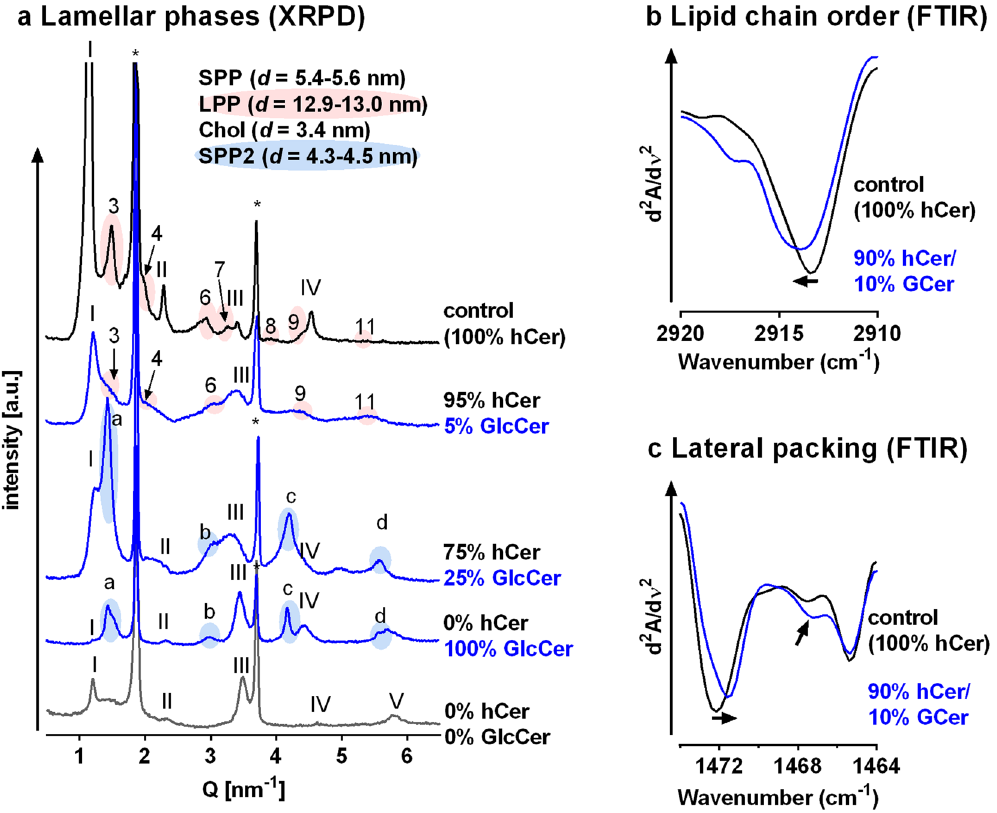
Figure 3. Lamellae phases, lipid chain order and lateral packing of selected hCer/GlcCer/FFA/Chol/CholS membranes studied using X-ray powder diffraction (XRPD; a ) and Fourier transform infrared spectroscopy (FTIR; b and c ). Roman numerals mark the short periodicity phase (SPP); Arabic numerals mark the long periodicity phase (LPP); asterisks mark crystalline cholesterol (Chol) reflections; and letters mark the additional short periodicity lamellar phase SPP2. The data in panels b and c are shown as second derivative spectra for clarity, and the arrows indicate the GlcCer-induced